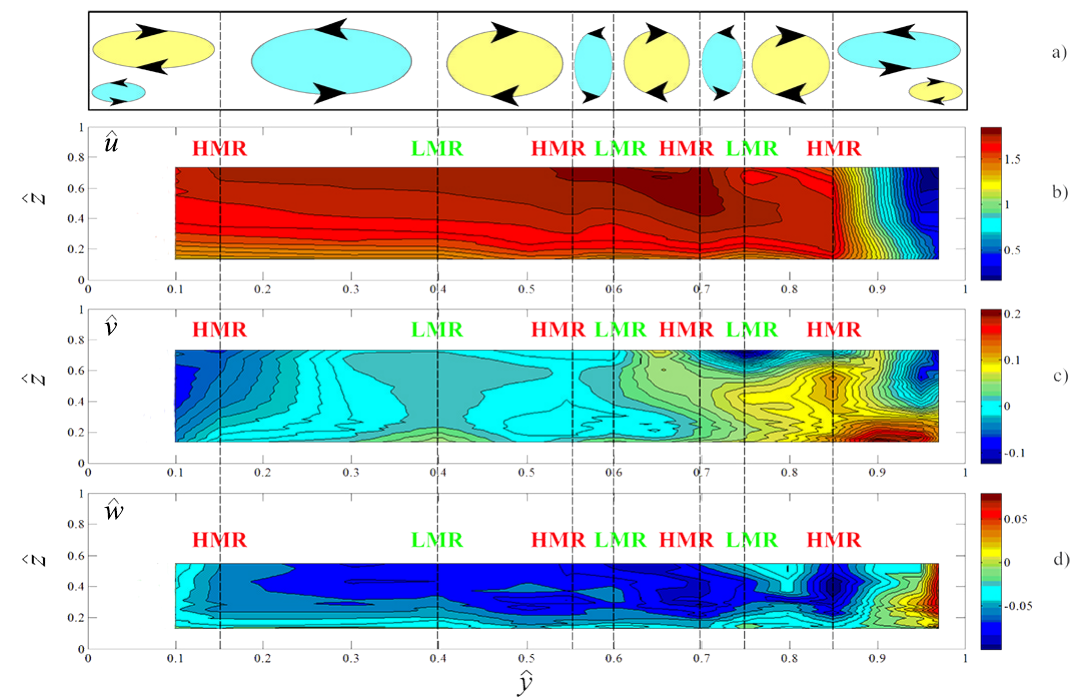
Figure 5. Patterns of some hydrodynamic variables at cross-section no. 7: ( a ) schematic of secondary currents; ( b ) normalized streamwise velocity component, ˆ u = ¯ u / U m 0 ; ( c ) normalized spanwise velocity component, ˆ v = ¯ v / U m 0 ; ( d ) normalized vertical velocity component, ˆ w = ¯ w / U m 0